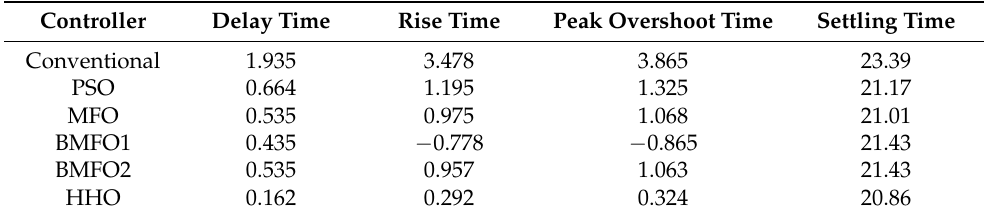
Table 5. Graph analysis of deviation in actual tie-line power flow with various controllers under unilateral contract.